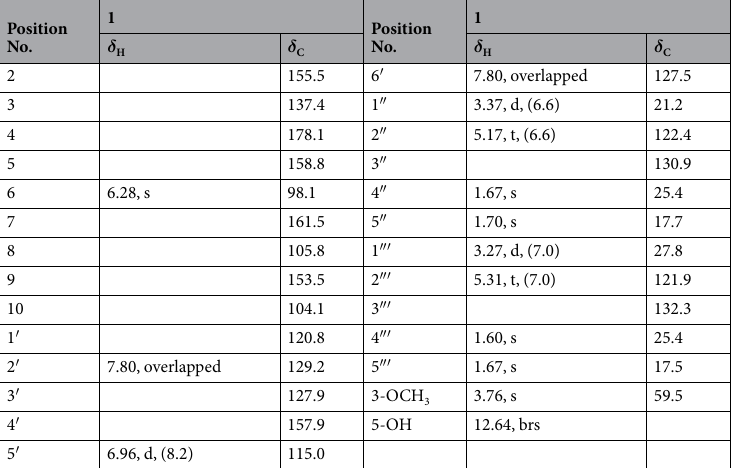
Table 1. 1 H (400 MHz) and 13 C (100 MHz) NMR data for daphnegiravone D in DMSO- d 6